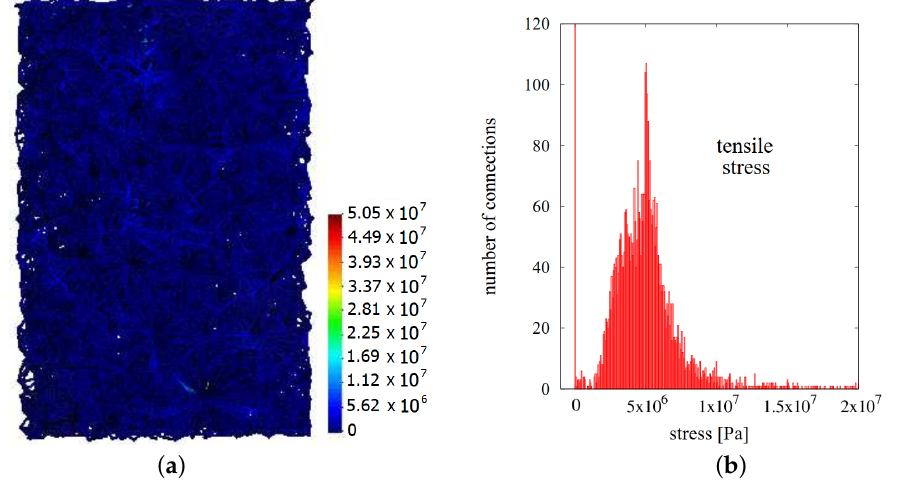
Figure 11. The results of sintering driving microscopic stresses at the final stage of sintering: ( a ) distribution in the volume and ( b ) histogram.